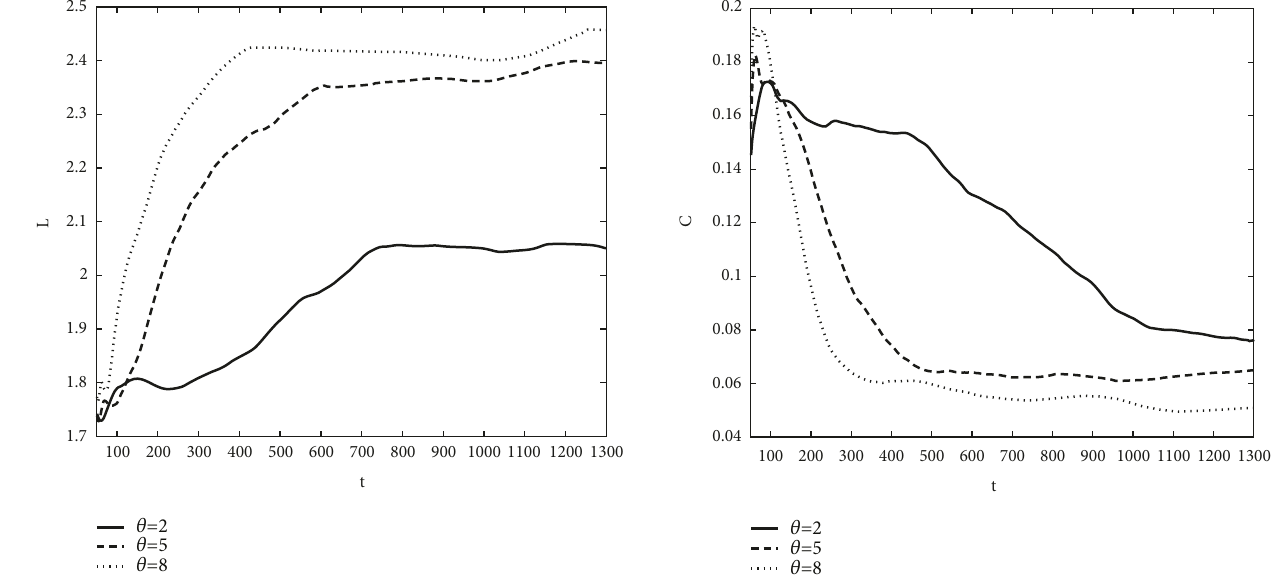
Figure 5: The evolution picture of the cluster innovation network average path length.